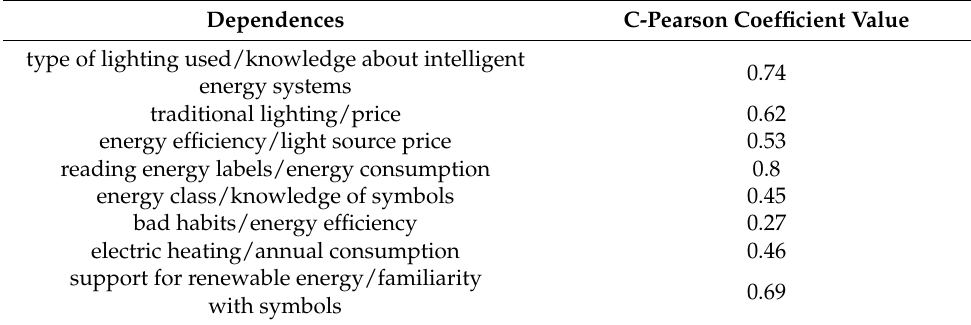
Table 11. The results of the C-Pearson coefficient at a significance level of